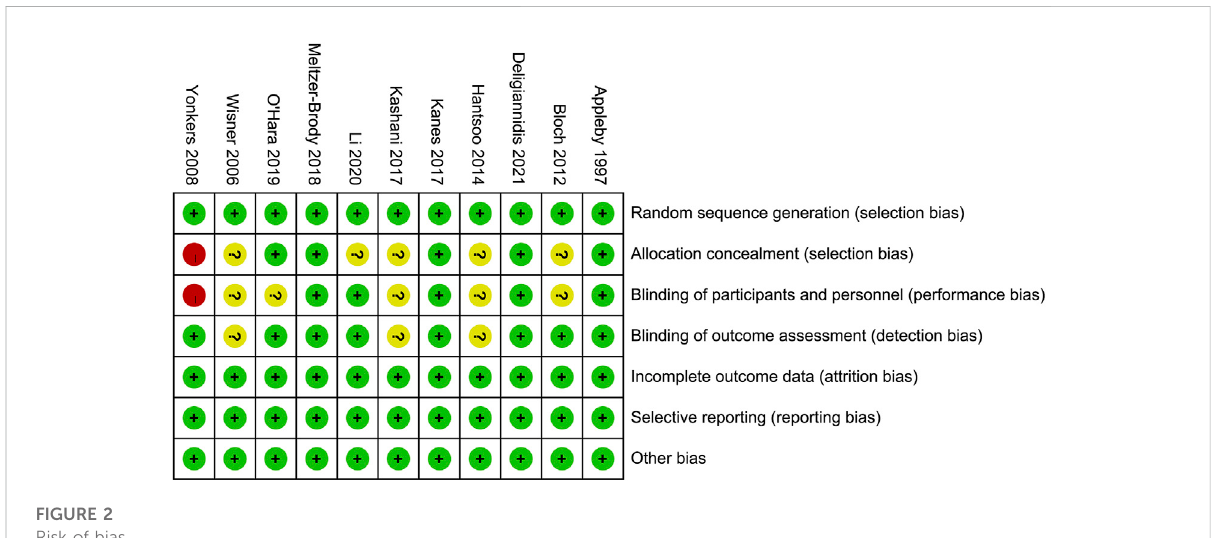
FIGURE 2 Risk of bias.